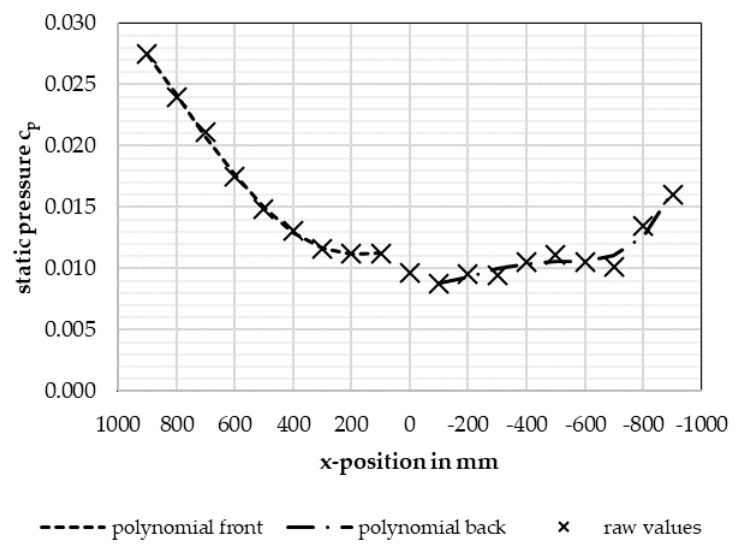
Figure 6. Static pressure distribution in the empty test section (sine signal; f = 1.5 Hz, A = 4.4 ◦ ). The Two-Measurement method uses the pressure difference between the position at the vehicle’s front bumper and a sensitivity point at the rear of the vehicle to correct the measured c D [1]. In order